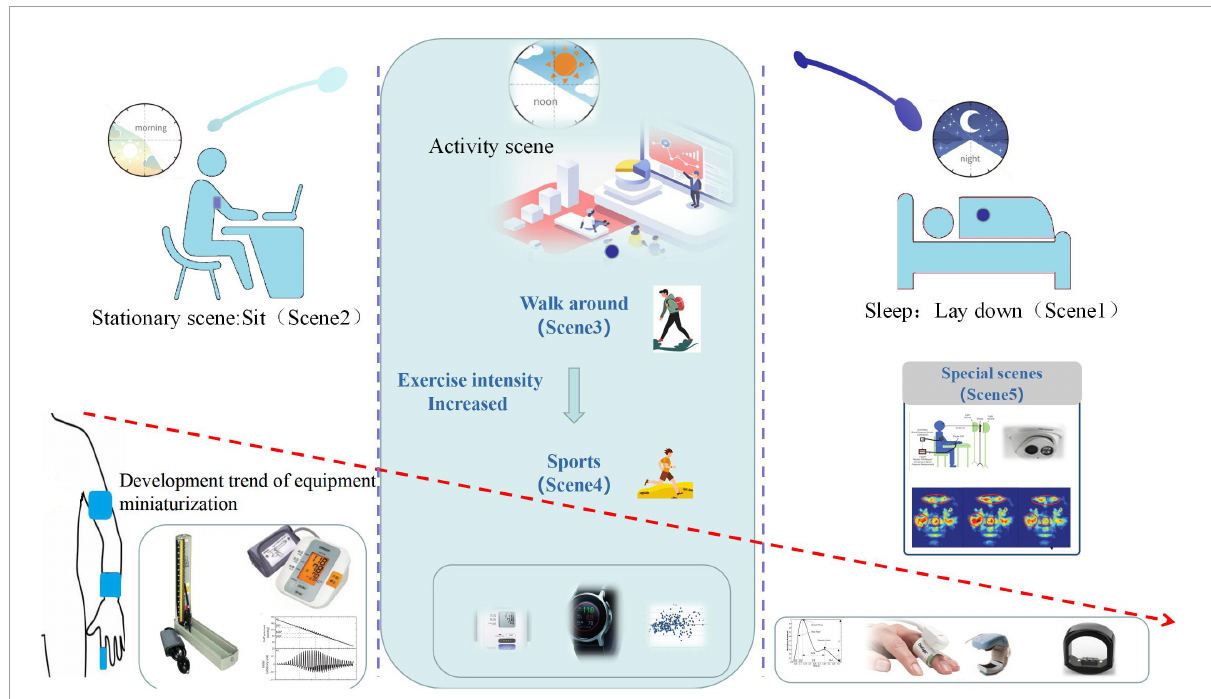
FIGURE1 Schematic diagram of scene based blood pressure monitoring. Timeline of 1 day from left to right describes morning to night. The descending arrow describes the trends of miniaturization devises and monitor positions from up arm to finger. The two vertical dotted lines distinguish stationary scene, activity scene and sleep scene, the typical monitoring devices are shown